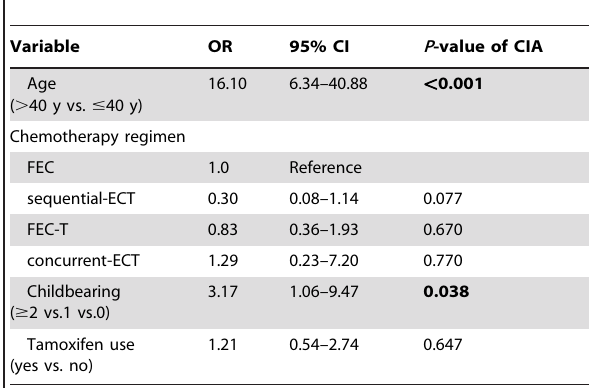
Table 3. Multivariate analysis of